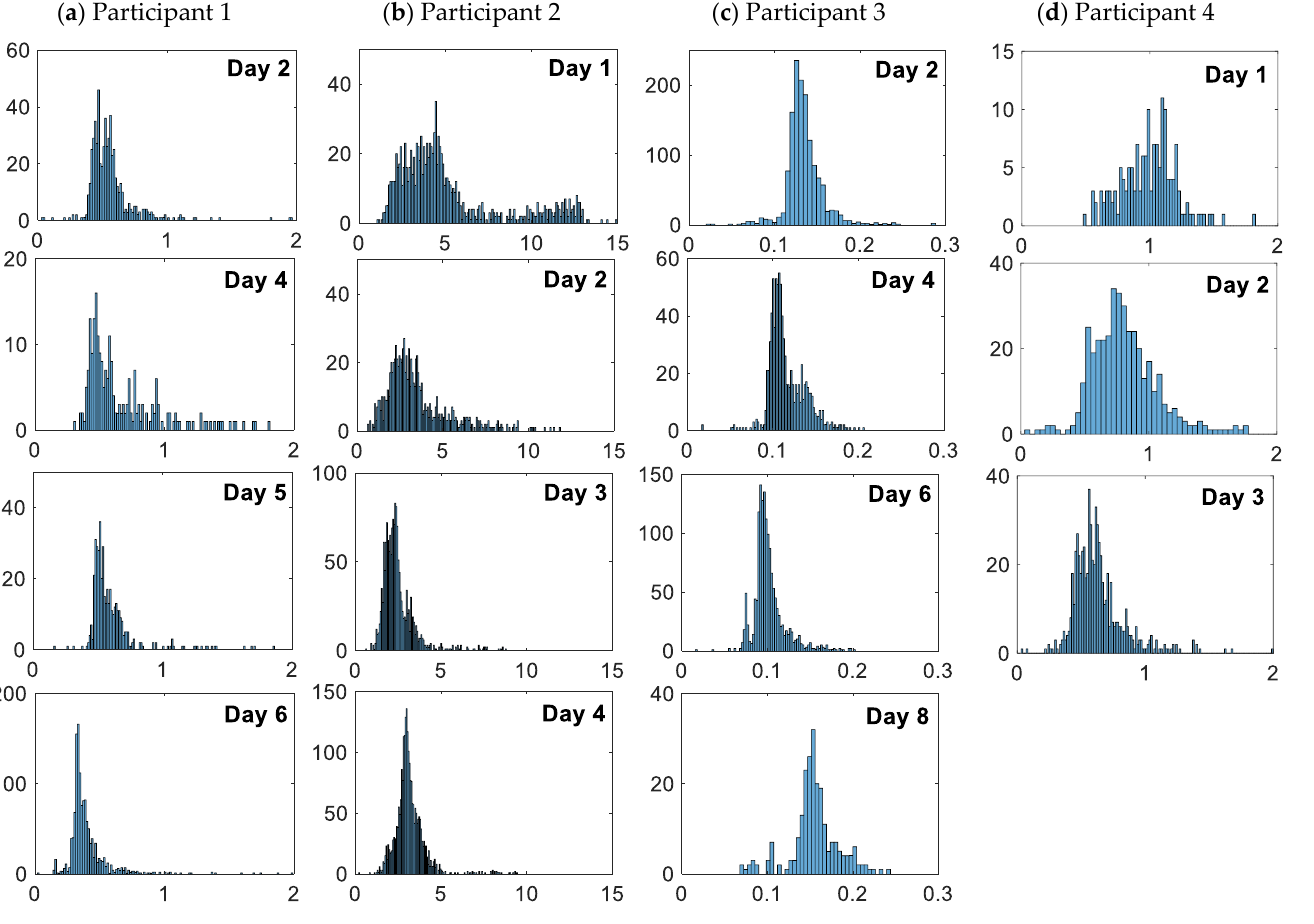
Figure 8. Histograms of cyclic vertical motion (amplitude). Y -axes are number of steps. X -axes are motion amplitude in mm. Data for the four participants are in columns ( a – d ). The histograms were widest for participant 2 and narrowest for participant 3. Most of the plots shows a positive skewness. Two peaks were visible in some of the days (e.g., participant 3 day 6).